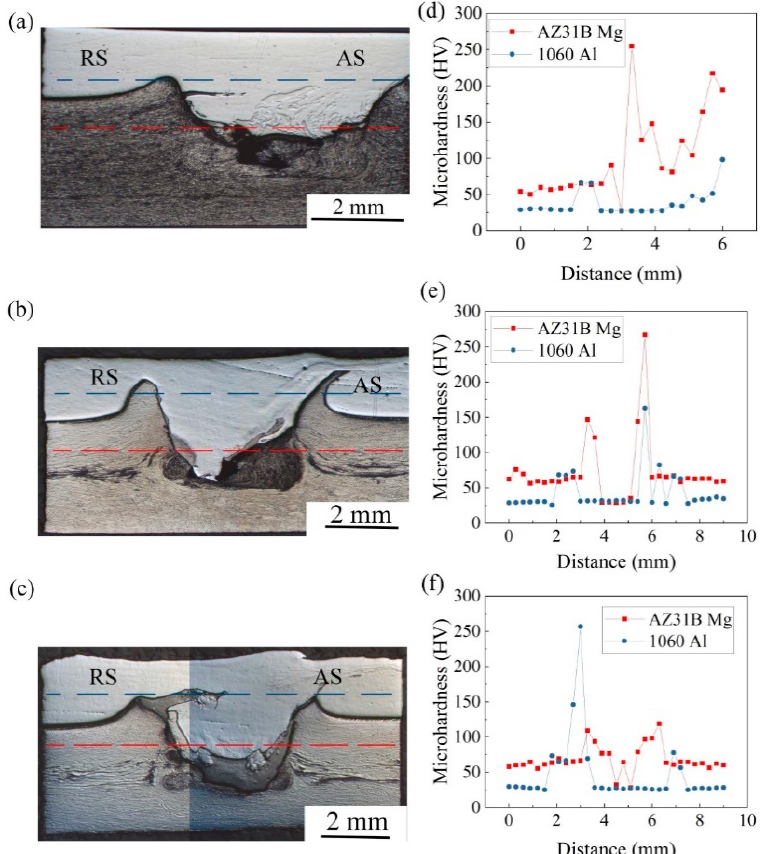
Figure 13. Cross-sectional appearance and micro-hardness of the joint: ( a , d ) P1, ( b , e ) P5, and ( c , f ) P7.